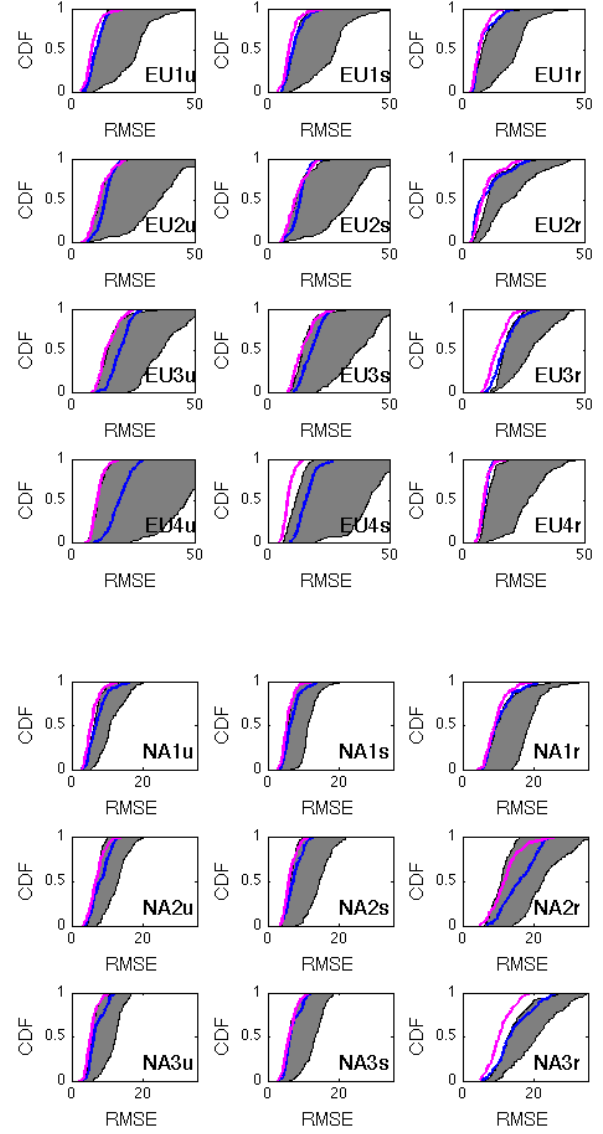
Fig. 10. The Cumulative density function of the RMSE distribution of the best and worst deterministic model is illustrated by the shaded area. The RMSE distribution of kz model (magenta) is always found in the leftmost side of the figure. The mm distribution is given in